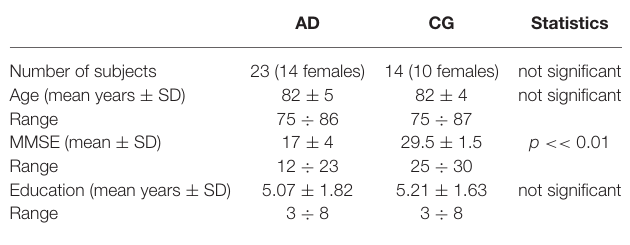
TABLE 1 | Demographic data of the Alzheimer’s disease (AD) patients and healthy age-matched participants (control group, CG). AD CG